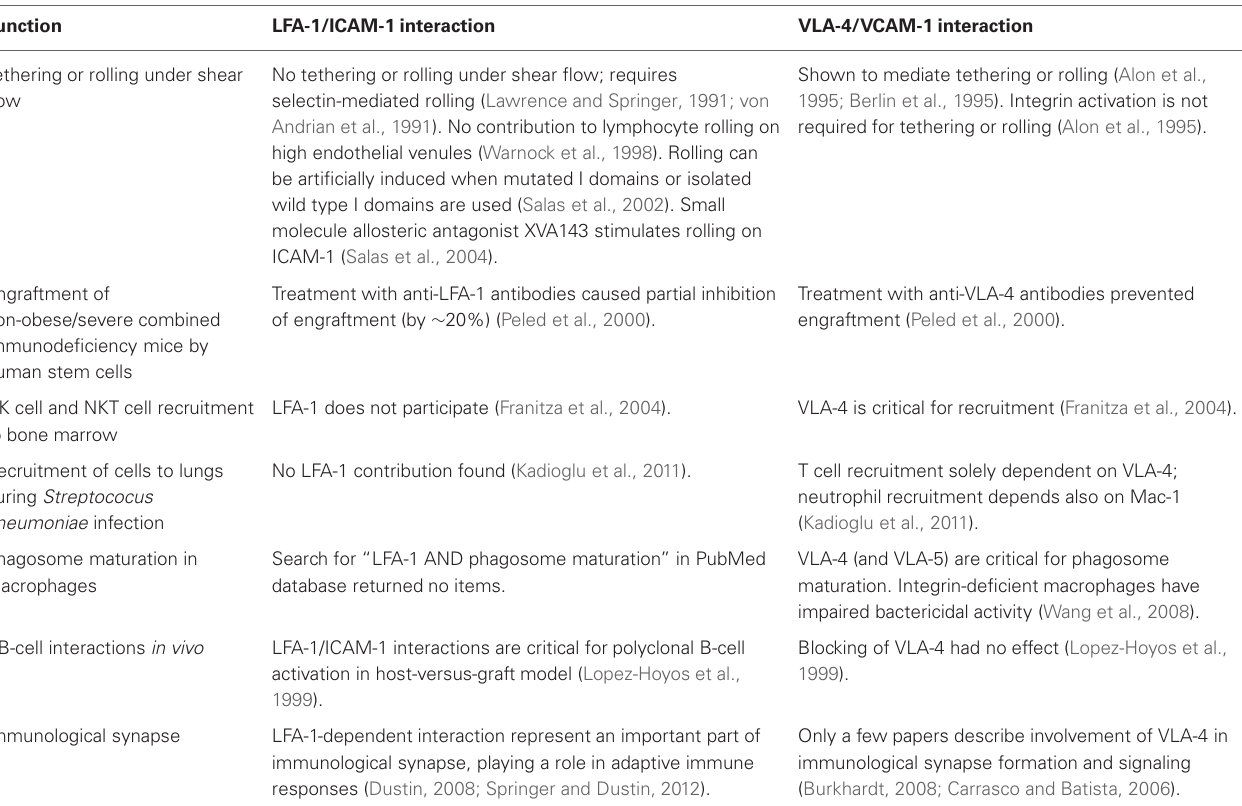
Table 1 | Examples of different functional roles of LFA-1 and VLA-4-dependent adhesive interaction. Function LFA-1/ICAM-1 interaction Tethering or rolling under